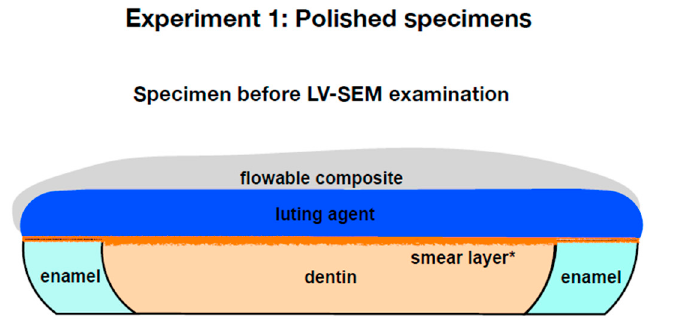
Figure 2. Polished specimens after preparation and before low vacuum scanning electron microscopy (LV-SEM) (experiment 1). For dual-curing mode (DC), specimens were polymerized for 60 s. A vertical limit-stop was used in order to better align the components of the specimens. For self-curing mode (SC), specimens were allowed to polymerize for 24 h isolated from light. * = smear layer was created by wet